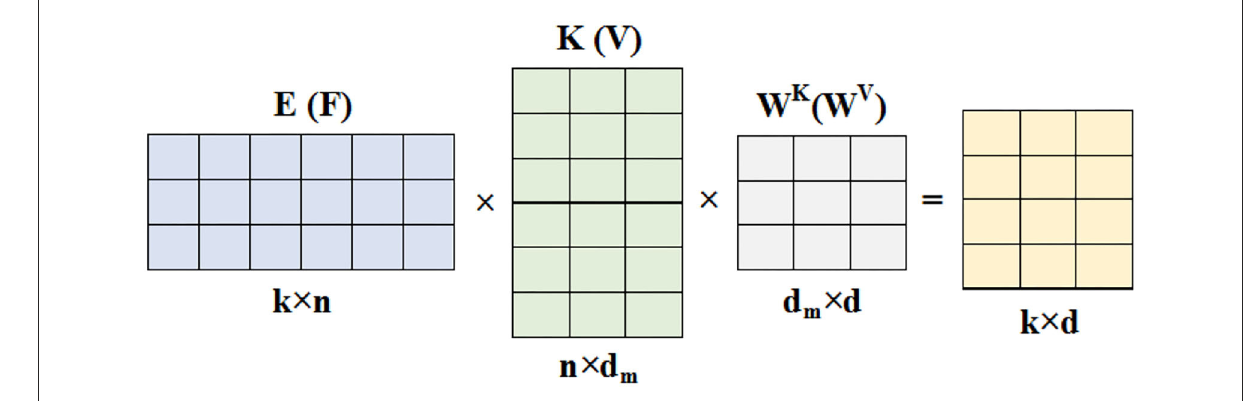
(Figure 2) is a low-rank approximation method, specifically adding two (k n)-dimensional linear projection matrices E and × F, respectively, when calculating Key and Value, which reduces the original Key and Value layer KW K and VW V from (n dimensional to (k d)-dimensional. as in Figure 3. The (n × dimensional contextual mapping matrix − P is then calculated by scaled dot-product, as in Equation